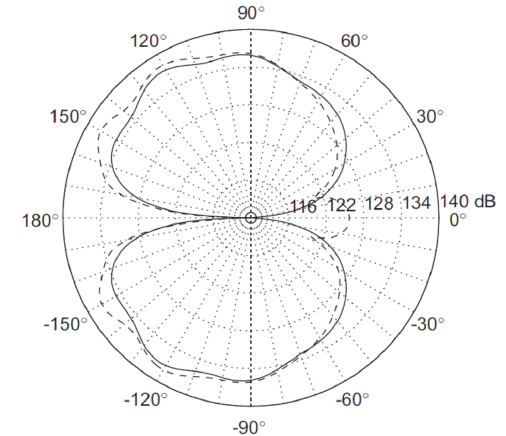
Figure 23. Comparison of acoustic feedback loop (AFL) acoustic directivity obtained from direct numerical simulations (DNS) (dashed line) and predicted using Amiet’s trailing edge (TE) noise theory (solid line). (Reprinted from [17], with permission from Elsevier).